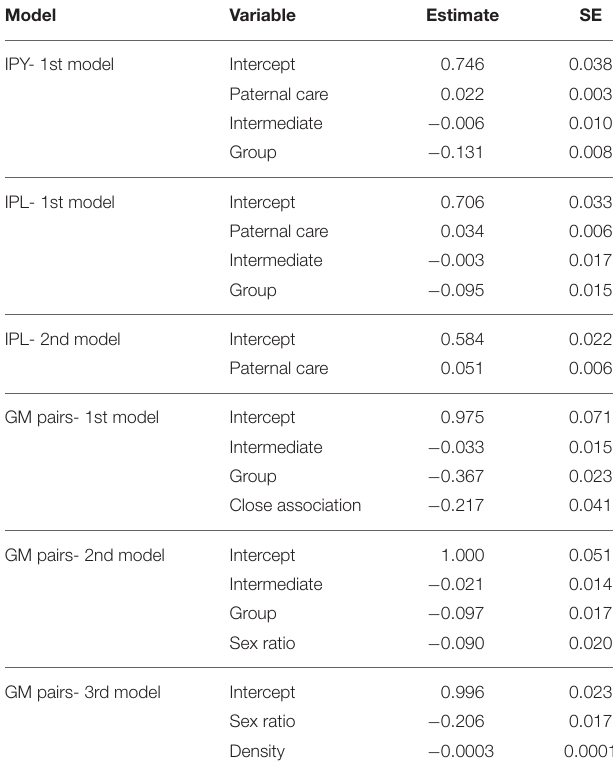
proportion of intra-pair young. =